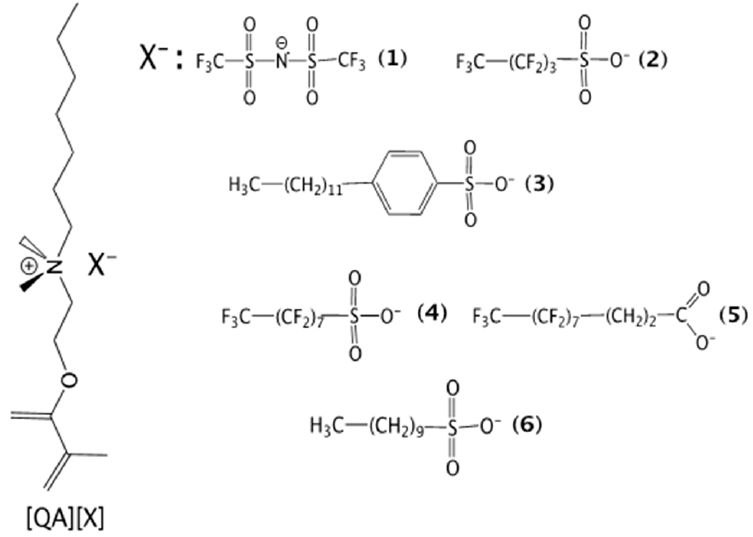
Figure 8. Schematic representation of the [QA][X], 1 - 6, IL series. The IL numbering is the same used in